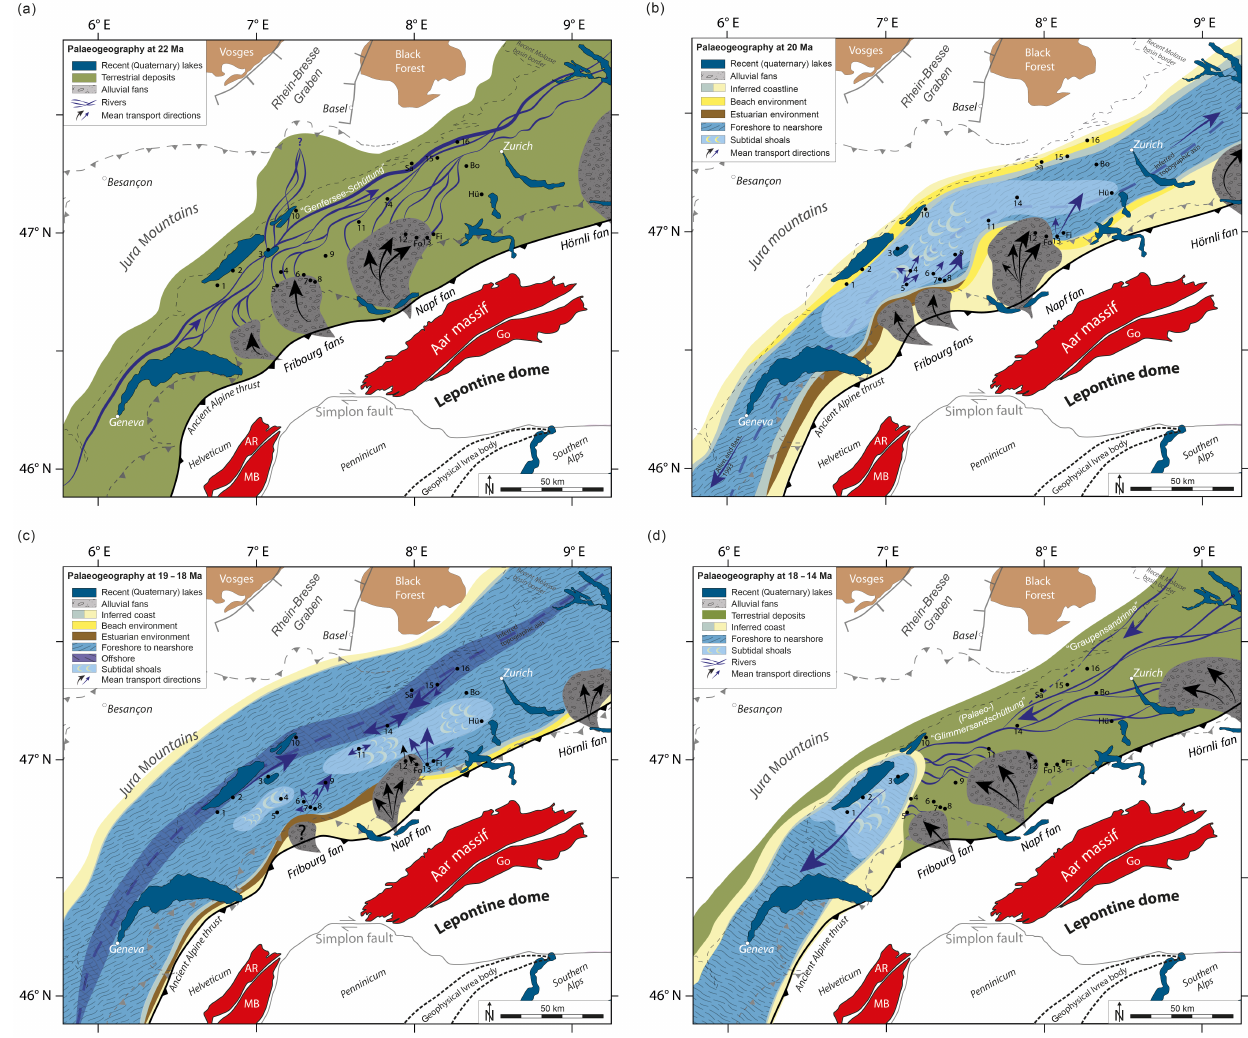
Figure 6. Palaeogeographical reconstructions of the Molasse basin at different stages: (a) USM (ca. 22Ma), (b) OMM-Ia (ca. 20Ma), (c) OMM-Ib (ca. 19–18Ma), and (d) OMM-II to OSM (ca. 18–14Ma) modified after Kuhlemann and Kempf (2002) and based on own observations. Note that all maps show present-day lithotectonic units within the Alps and the Jura Mountains for orientation purposes (dashed lines and grey lines). We acknowledge that the positions of these and the surface patterns (such as lakes) were different during the deposition of the Molasse deposits. The location of the palaeo-thrust fronts (thick lines) are adapted from Kuhlemann and Kempf (2002). Black dots mark study sites for orientation purposes. Please refer to Fig. 1 for the complete